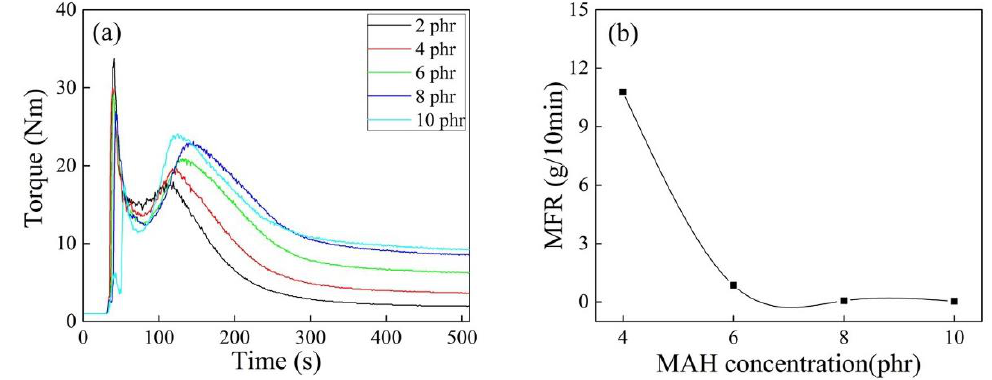
Figure 7. Torque/time spectra ( a ) and MFR ( b ) of iPB-g-MAH at different MAH concentrations. ( T = 180 °C, DCP = 0.6 phr, DVB/MAH = 4:6).